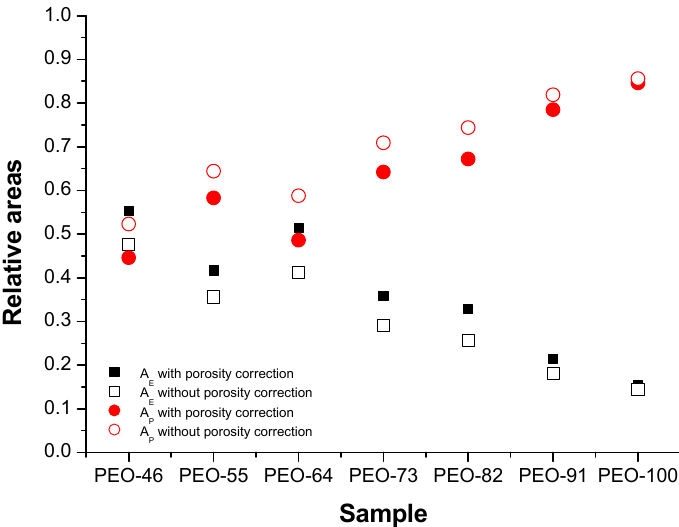
Figure 8. Elastic-plastic behavior of the different PEO-based materials before (circles) and after (squares) considering porosity.